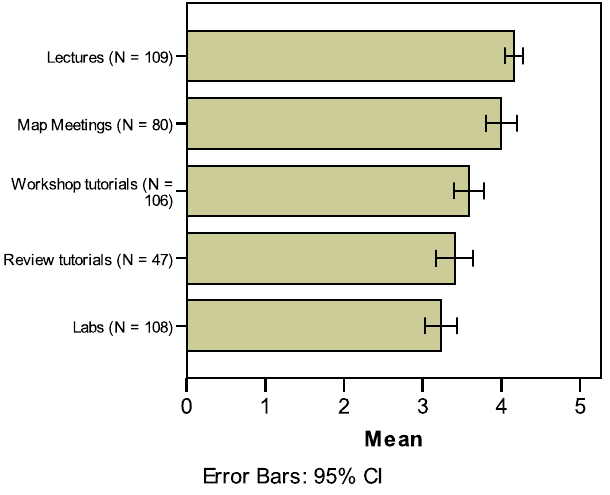
FIG. 7. (cid:1) Color online (cid:2) Student response to the statement “I do not come to map meetings because … . ”